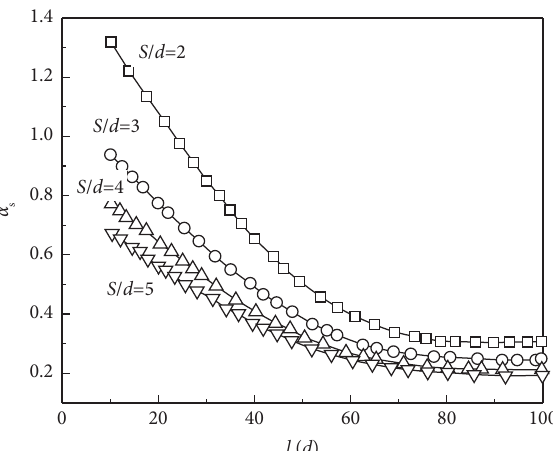
Figure 14: Infuence of Poisson’s ratio on interaction factor α